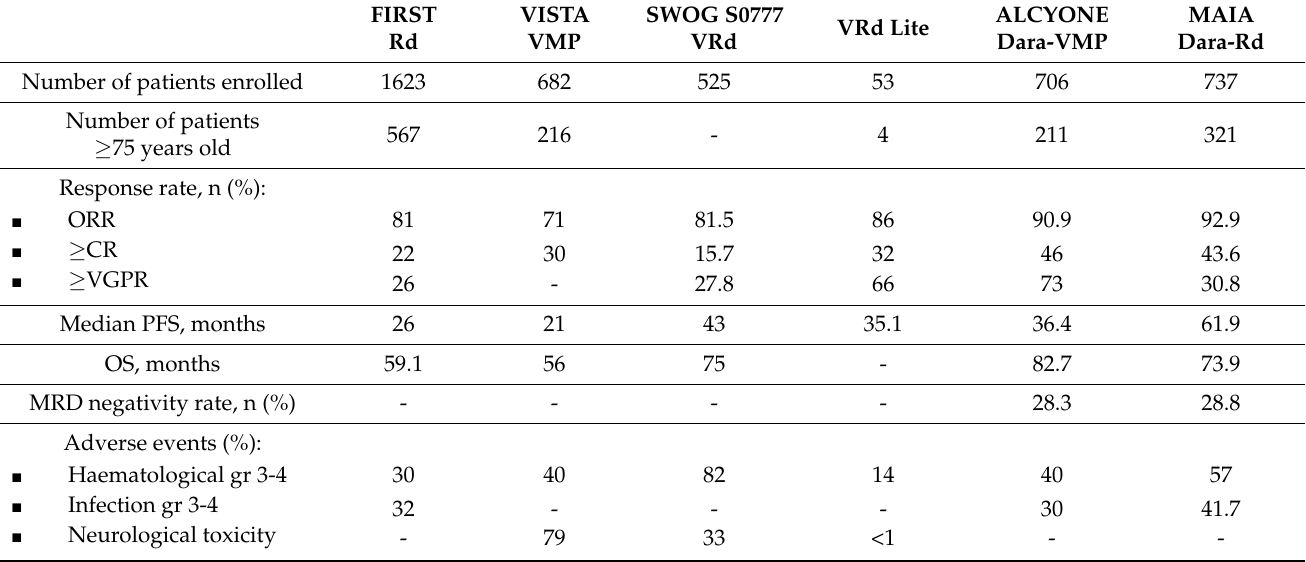
Table 1. Overview of treatment in NTE